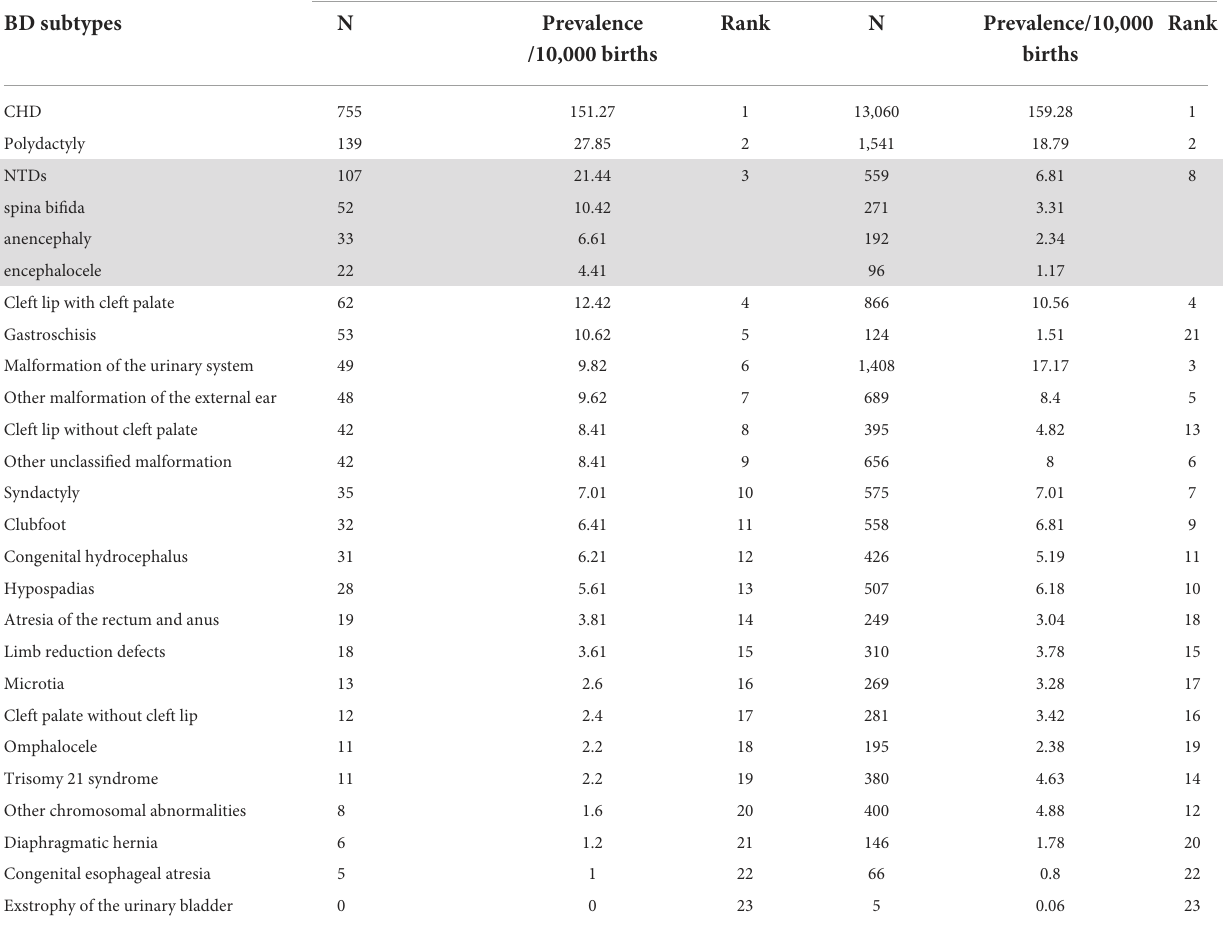
TABLE 2 Prevalence and ranking of 25 BD subtypes by maternal